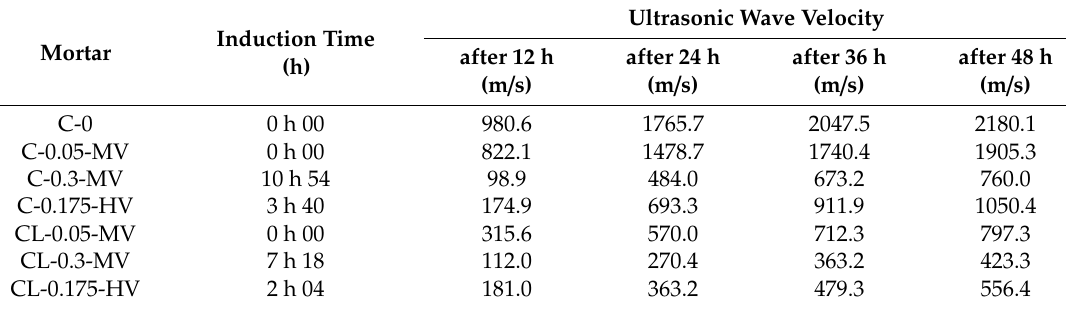
Figure 2. Ultrasonic wave velocity changes in all mortars (according to Table 3). Table 4. Comparison of results read from the graphs (Figure 2).